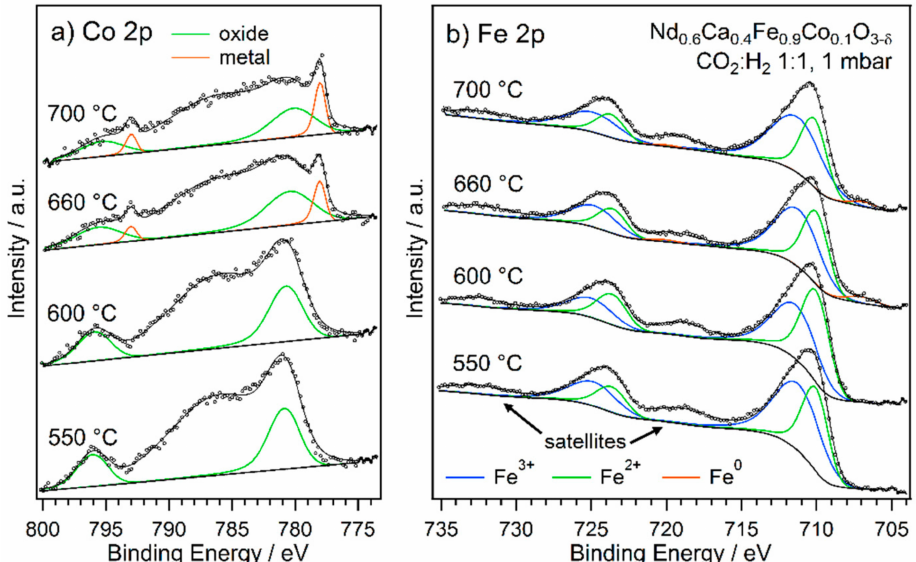
Figure 7. NAP-XPS spectra of the ( a ) Co 2p and ( b ) Fe 2p regions of Nd 0.6 Ca 0.4 Fe 0.9 Co 0.1 O 3- δ in rWGS atmosphere with a CO 2 to H 2 ratio of 1:1 at increasing temperatures. Both species are initially present as oxides, but a metallic component starts to become visible from 660 ◦ C. While approximately stable for Fe, it is growing for Co. Overlapping Auger peaks and satellites have been omitted for clarity.